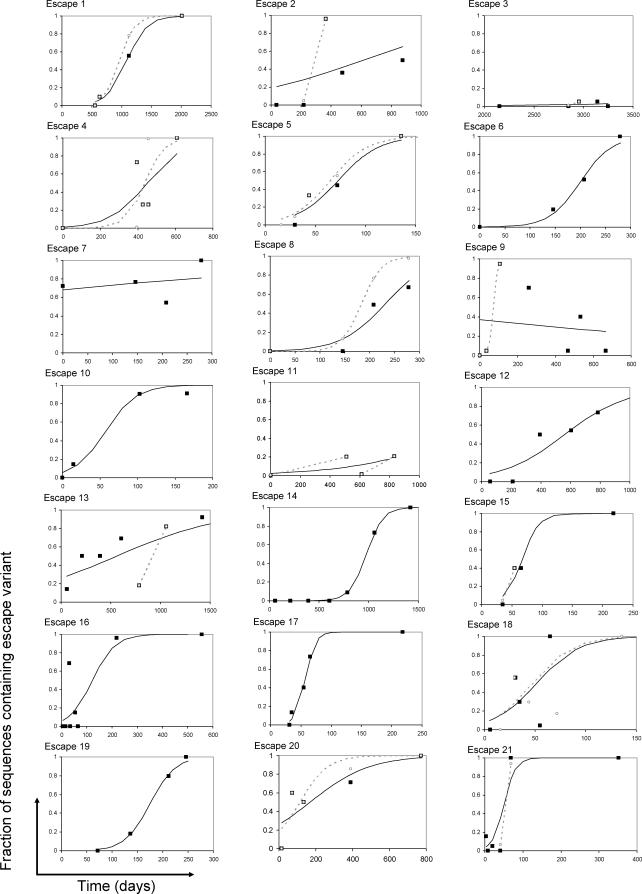
Escape Data and Theoretical FitsFit of the model to the experimental data for each of the 21 escape datasets. Best (filled squares) and optimistic (open circles) data and the fit of the model (solid line and dashed line, respectively) to the data. Best estimates of the escape rate of a variant were obtained by fitting the model to the published data. Maximal, “optimistic” estimates of CTL efficiency were also made by omitting data or including mutations that have not been shown to confer escape (e.g., in the case of fluctuating variant frequencies rather than steady outgrowth a more optimistic estimate can often be obtained if some later data are discarded, e.g., Escape 9). These maximal estimates are less accurate but they provide an approximate upper bound on the rate of escape.